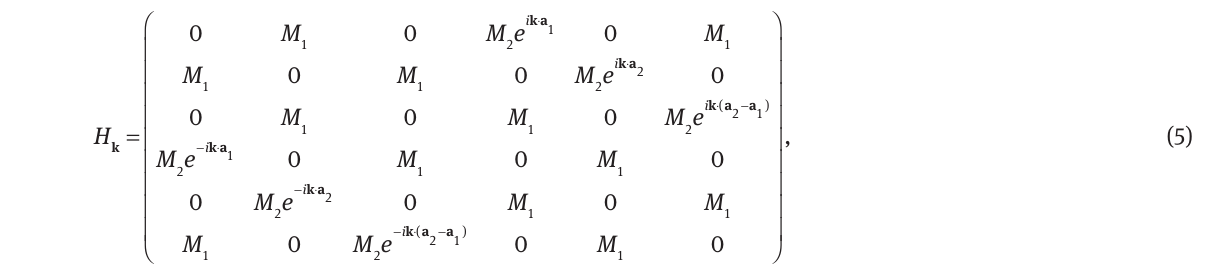
Figure 3. As the results of Figure 3 illustrate, in this sub- wavelength regime, the band gap, the frequencies over which transmission is minimum, remains unchanged for various lattice constants, as expected from the analytical